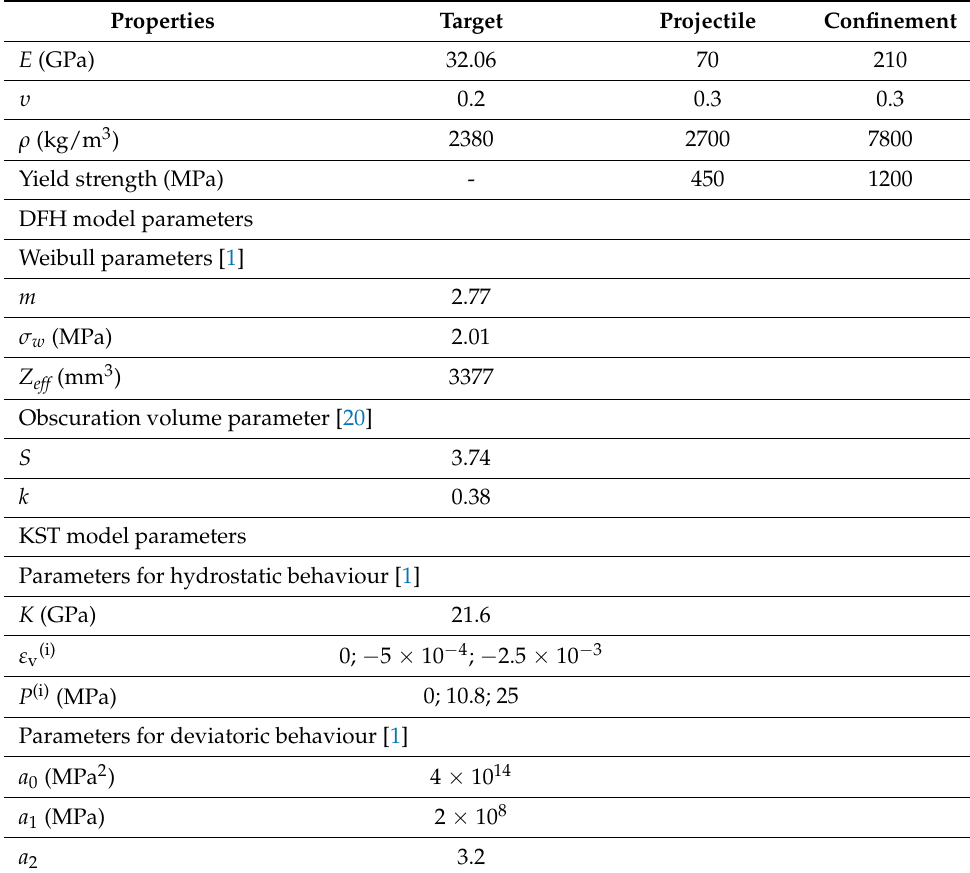
Table 4. Material parameters used in the numerical